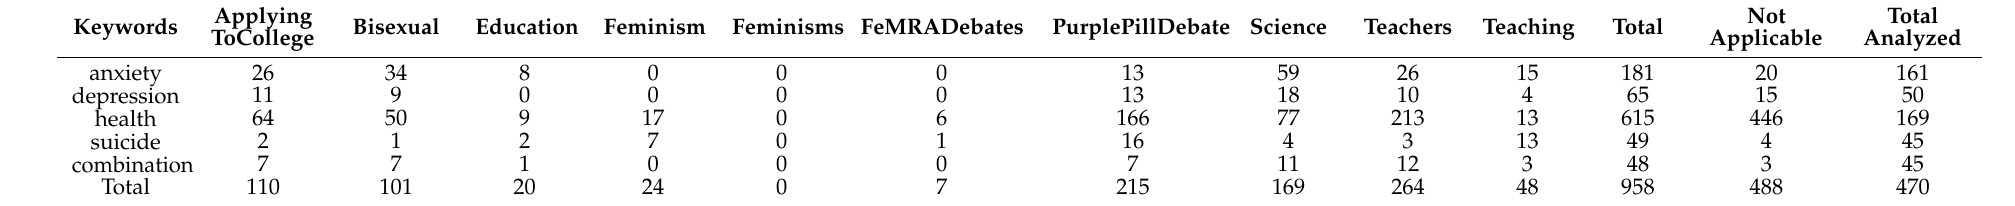
Table 2. Posts analyzed by keyword and